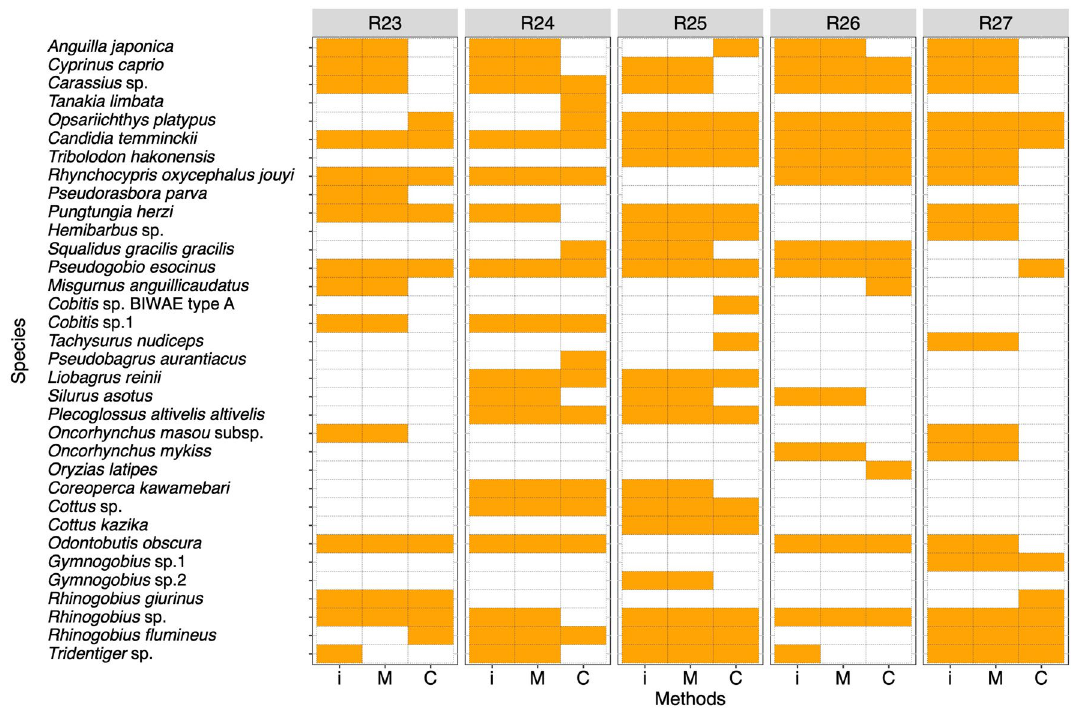
Figure 3. Heat map for comparison of the species compositions between high throughput sequencers and conventional methods in 5 river samples. Orange and white cells show the detection and non-detection of the species in each method. Abbreviations of “i”, “M”, and “C” indicate iSeq, MiSeq, and Conventional methods, respectively. Figure was created using “ggplot2” package version 3.3.0. supported on R program software 45 . Df † Sum of square Mean square F value R 2 Pr (>